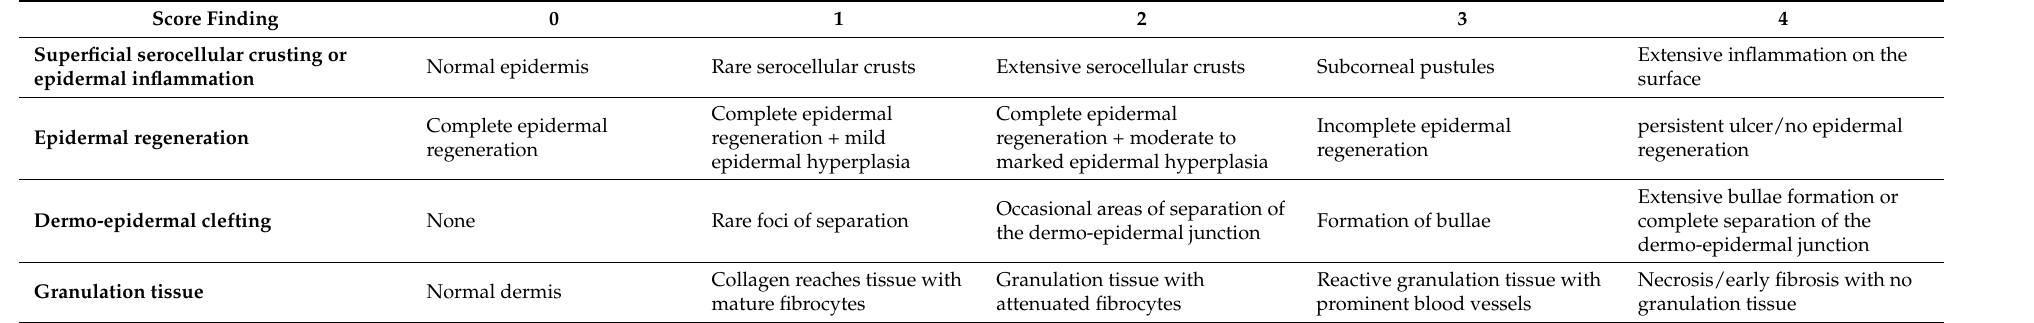
Table A1. Semiquantitative Histological evaluation system.